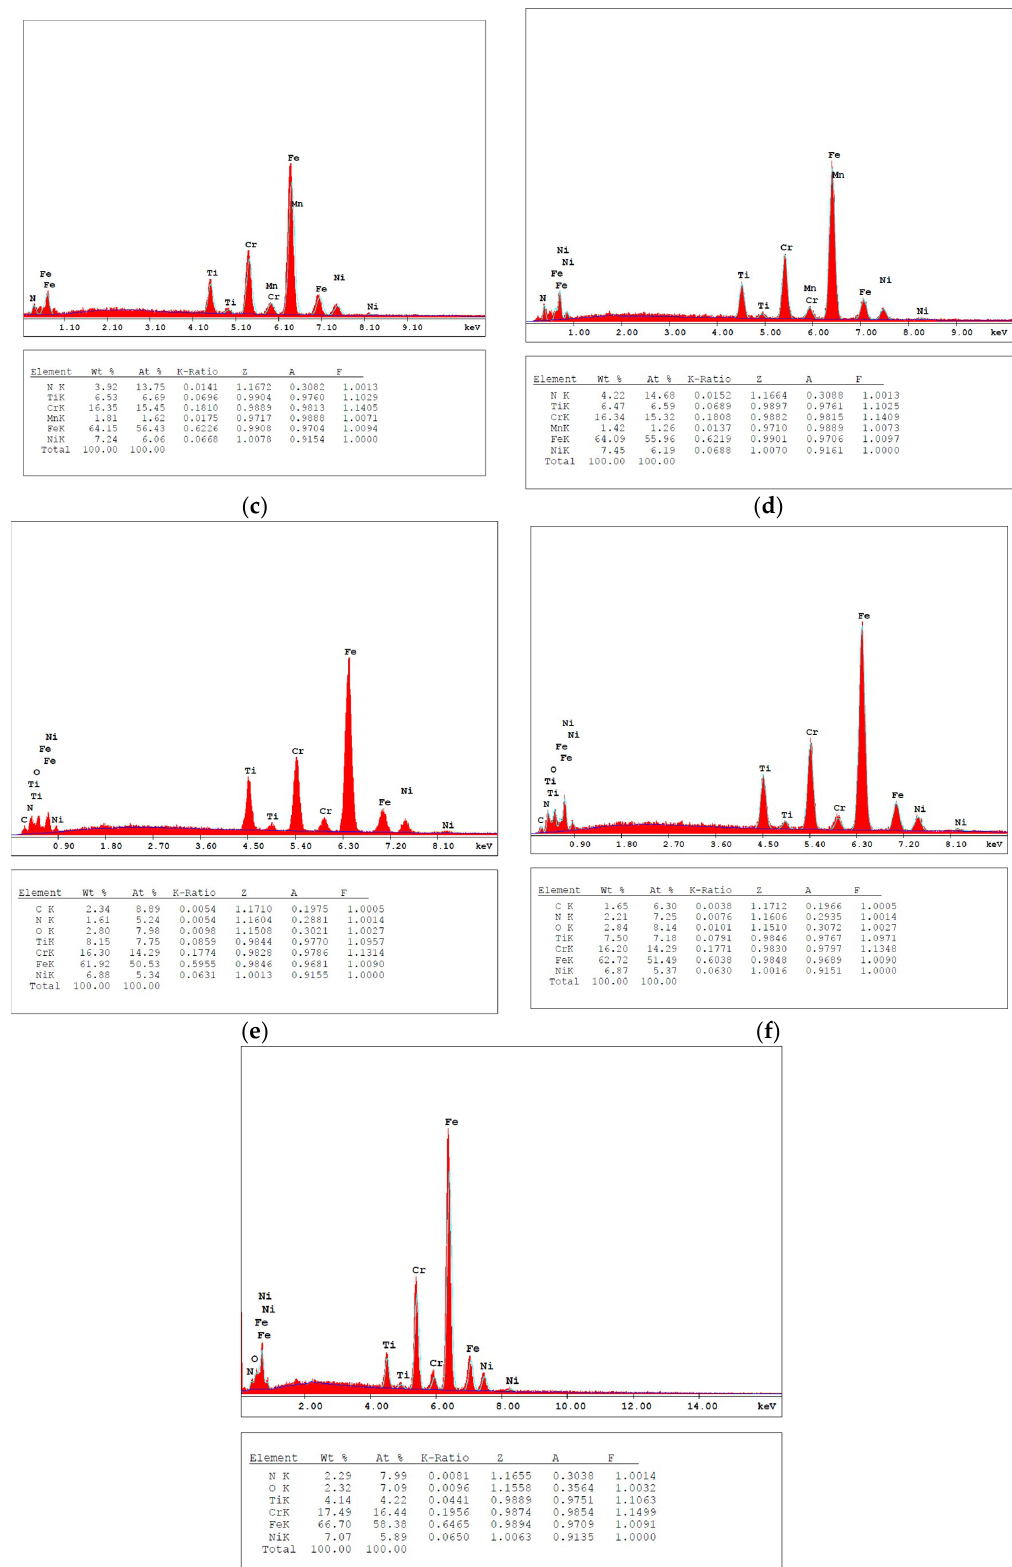
Figure 2. EDX of TiN ( a , b ), annealed TiN at 400 °C in vacuum ( c , d ), annealed TiN at 400 °C in air ( e , f ), and TiN x O y ( g ).